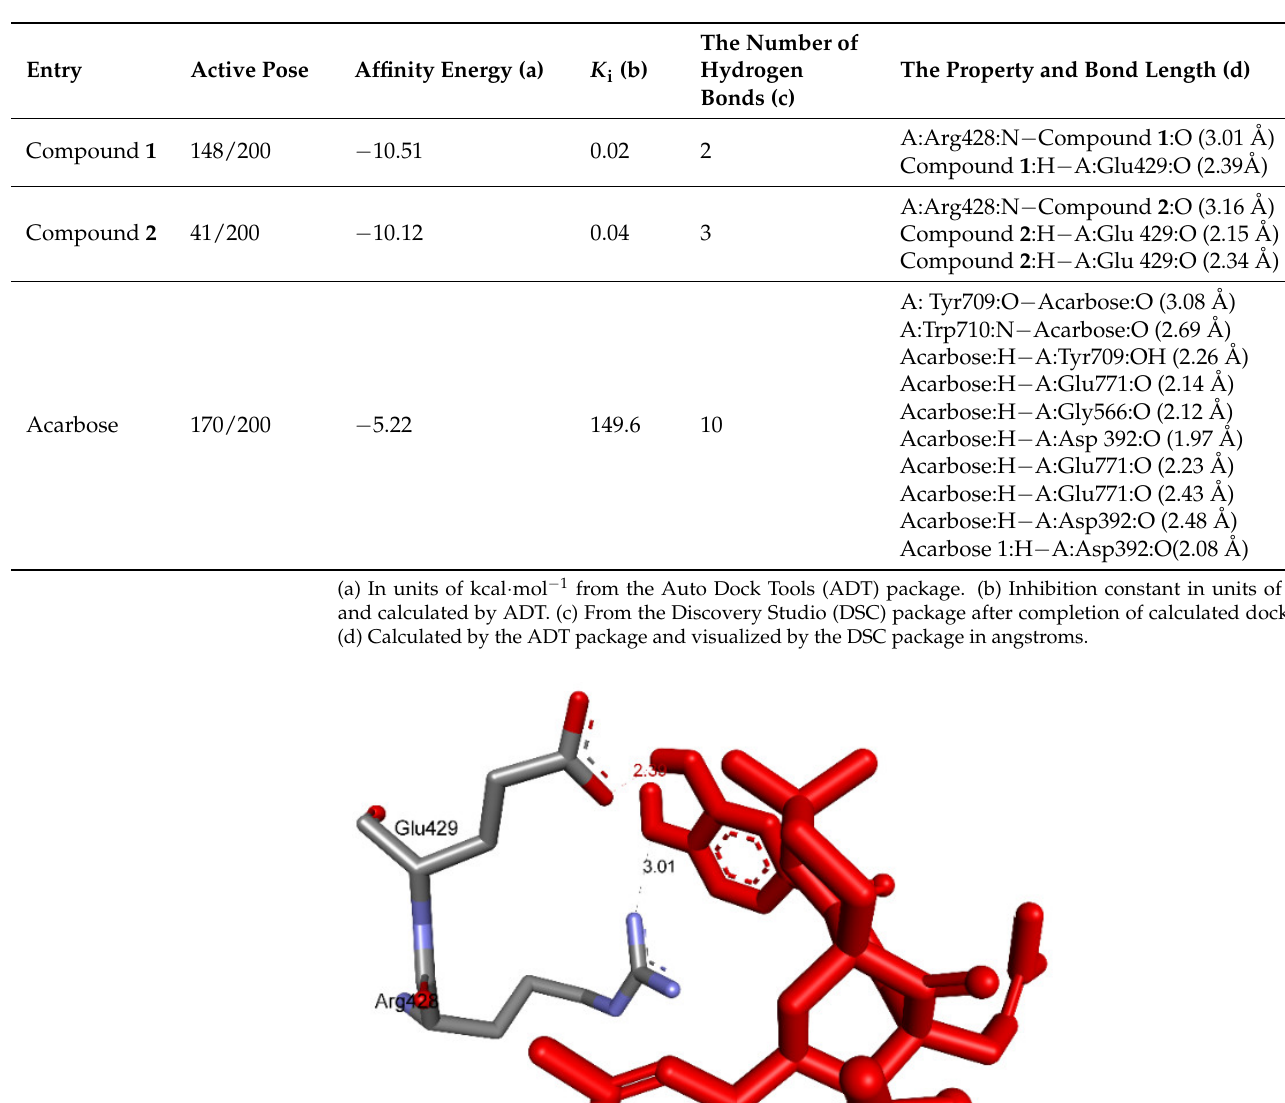
Table 2. The significant calculation results for the in silico molecular docking α -glucosidase enzyme inhibition model of compounds or ligands to one receptor, α -glucosidase enzyme 4J5T (PDB).